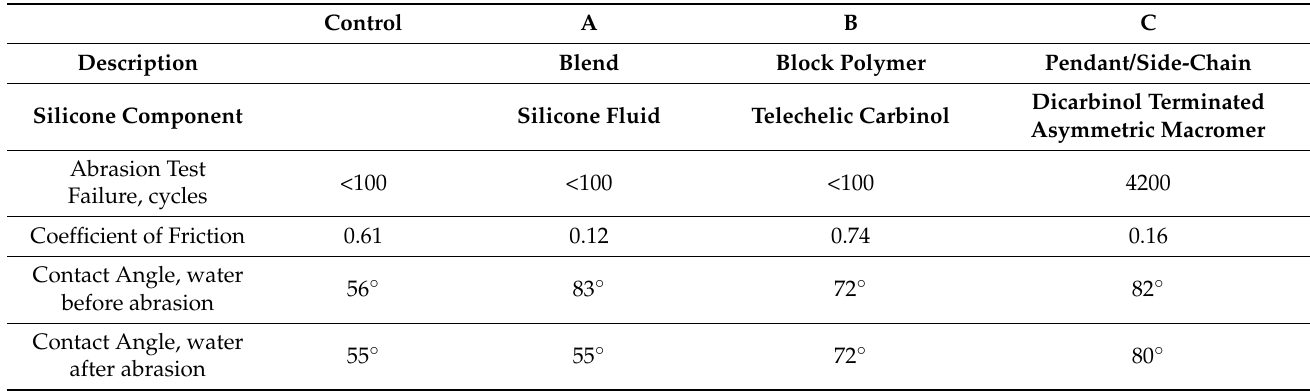
Table 8. Comparing Contact Angle, Abrasion, and Friction in an IPDI-based Urethane.